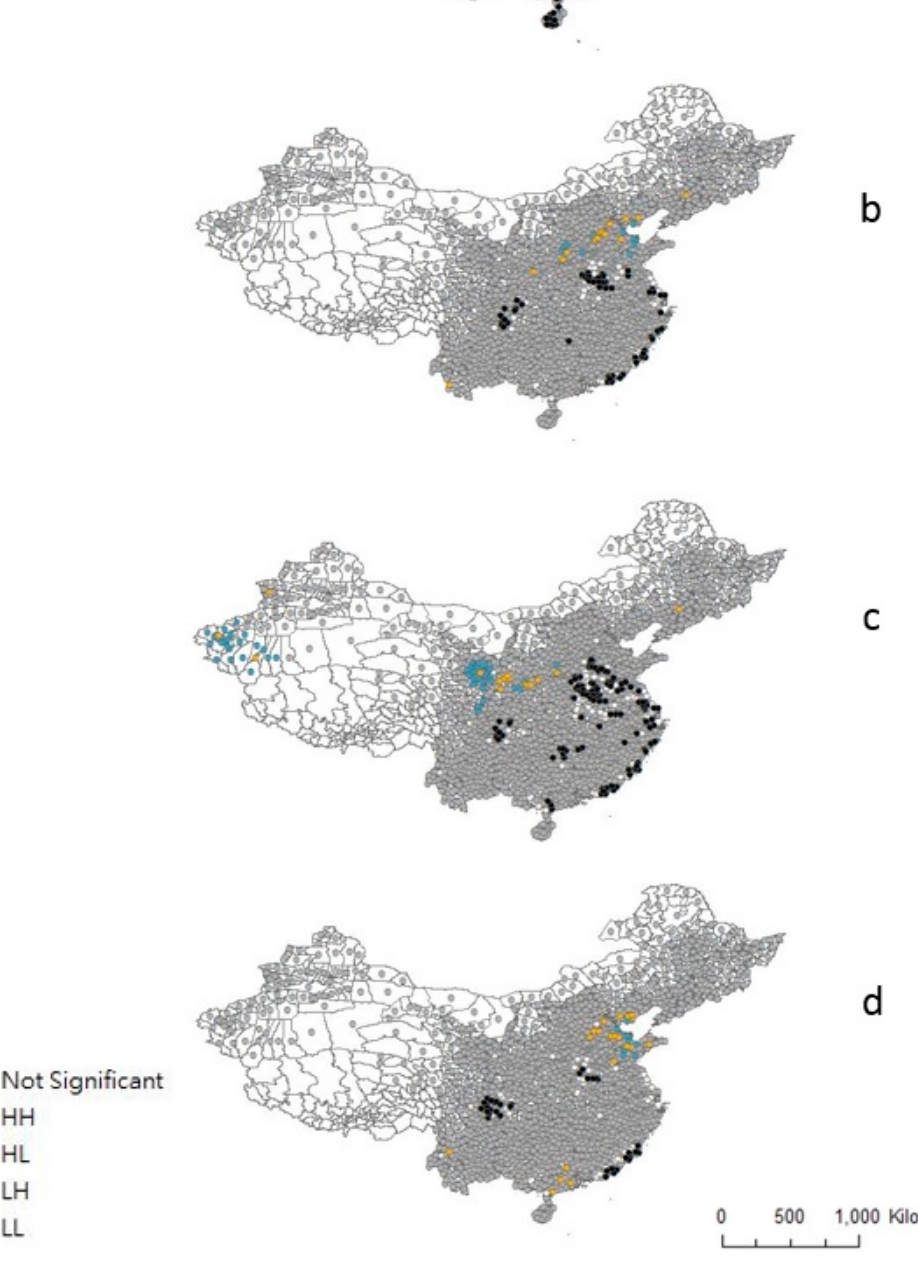
Figure 4. Spatial maps of local Moran’s I coefficient based on ( a ) OLS, ( b ) GWR, ( c ) NNGWR, and ( d ) ANNGWR in 2007.